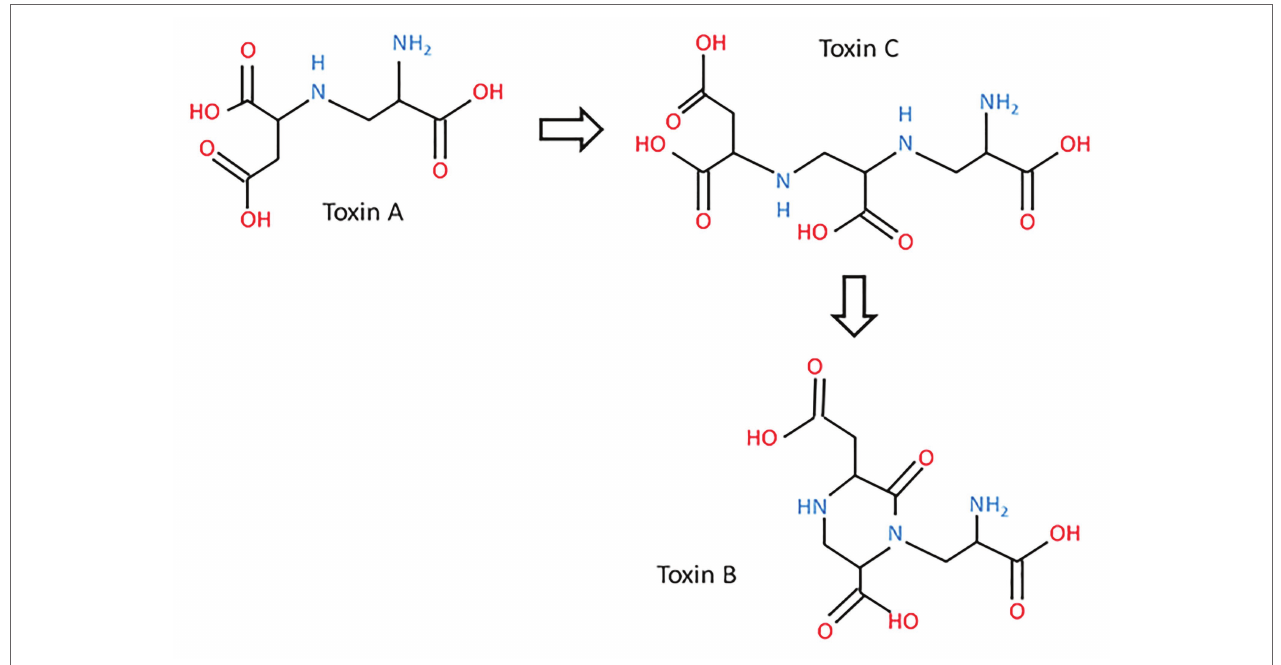
FIGURE 3 | The biosynthetic pathway of aspergilomarasmine A (toxin C) and its derivatives (toxin A and toxin B) and their chemical structures (inspired from Friis et al.,